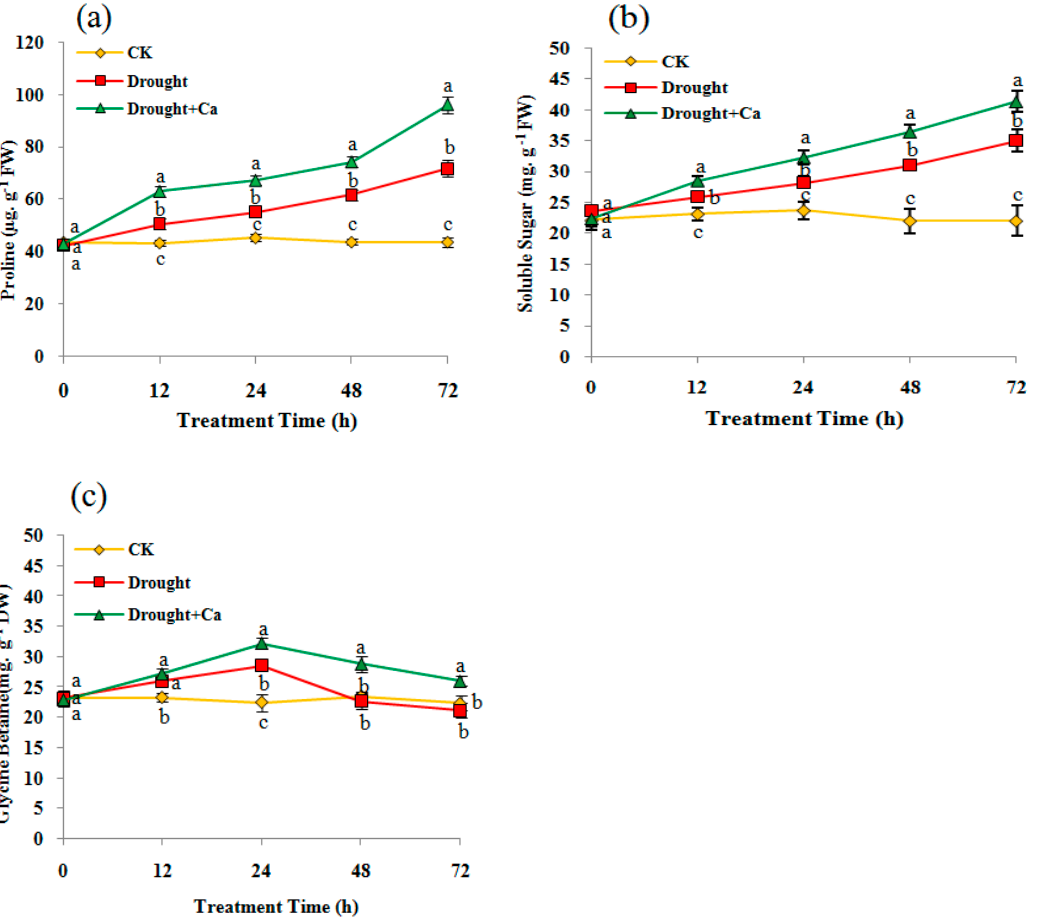
Figure 4. ( a ) Proline content, ( b ) Soluble sugar content, ( c ) Glycine betaine content in C. glauca leaves under drought stress and amended with Ca 2+ . The details of the treatments are given in the legend of Figure 2.